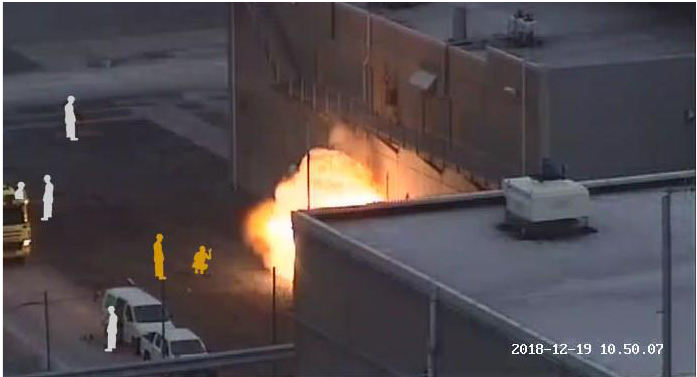
Figure 1. Closed-circuit television (CCTV) photo including location of personnel during the explosion (in grey) and approximately one minute earlier (in yellow) [16].